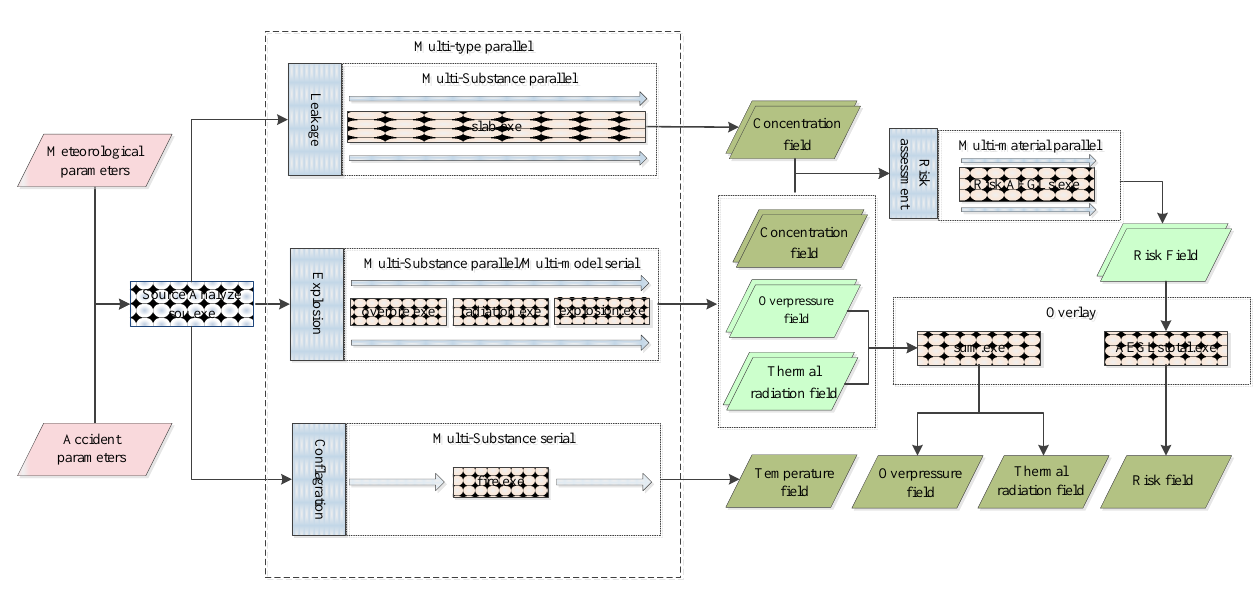
Figure 2. Flow chart of the model